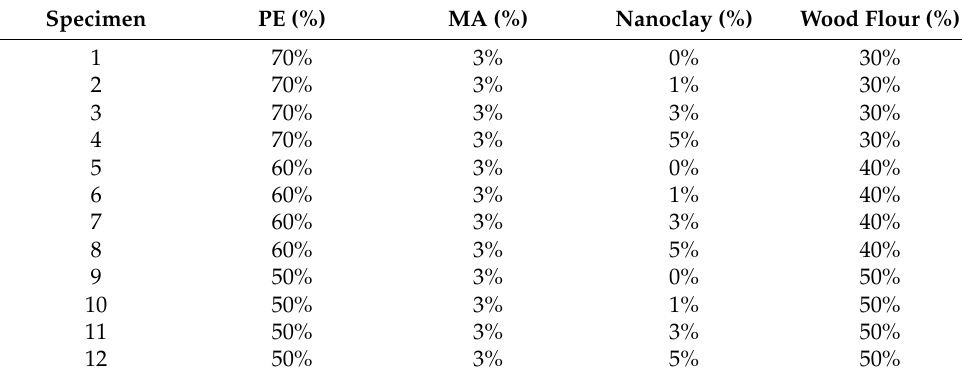
Table 4. The number of compounds in each specimen.